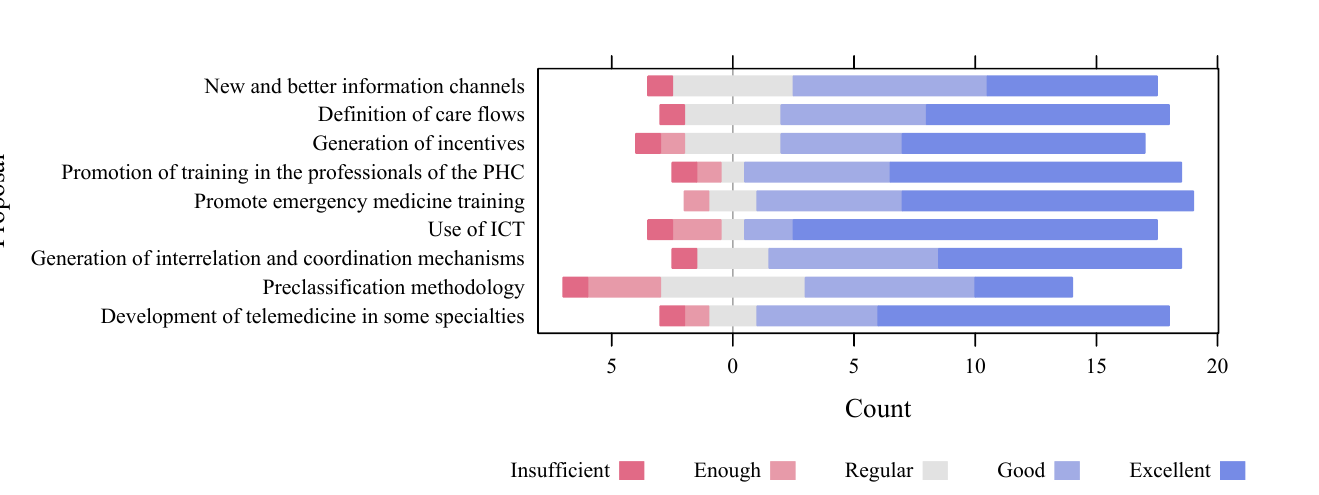
Figure 3. Valuation of proposals for improvements by experts in Emergency Medicine, with 21 responses